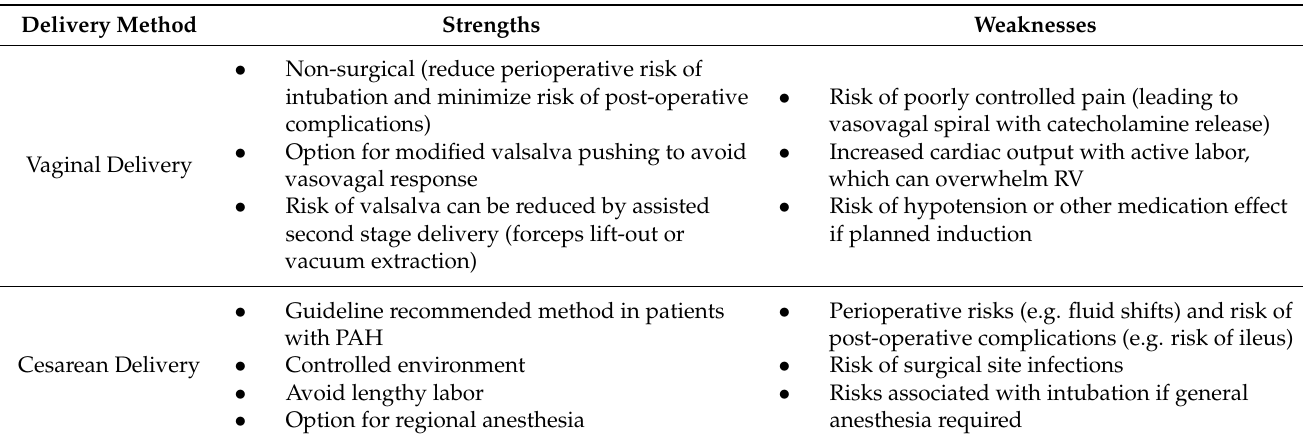
Table 2. Strengths and weaknesses of delivery methods for patients with PAH undergoing childbirth.